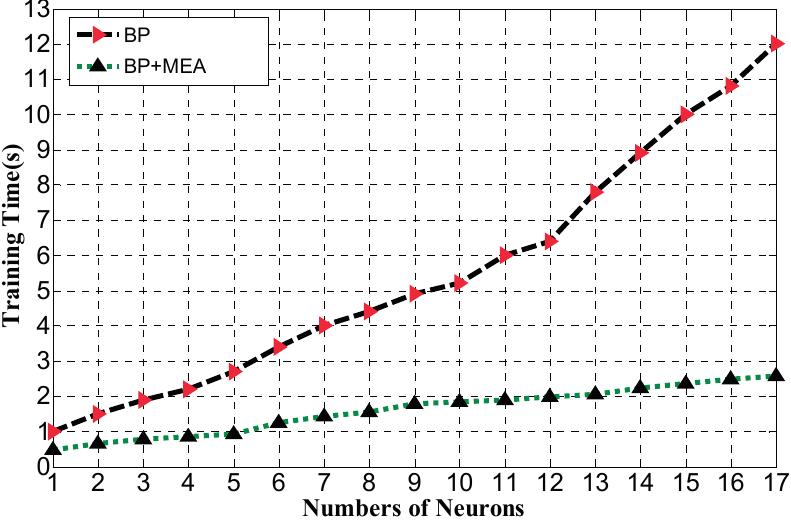
Figure 11. Training time comparison between BP and BP optimized by MEA for various numbers of hidden